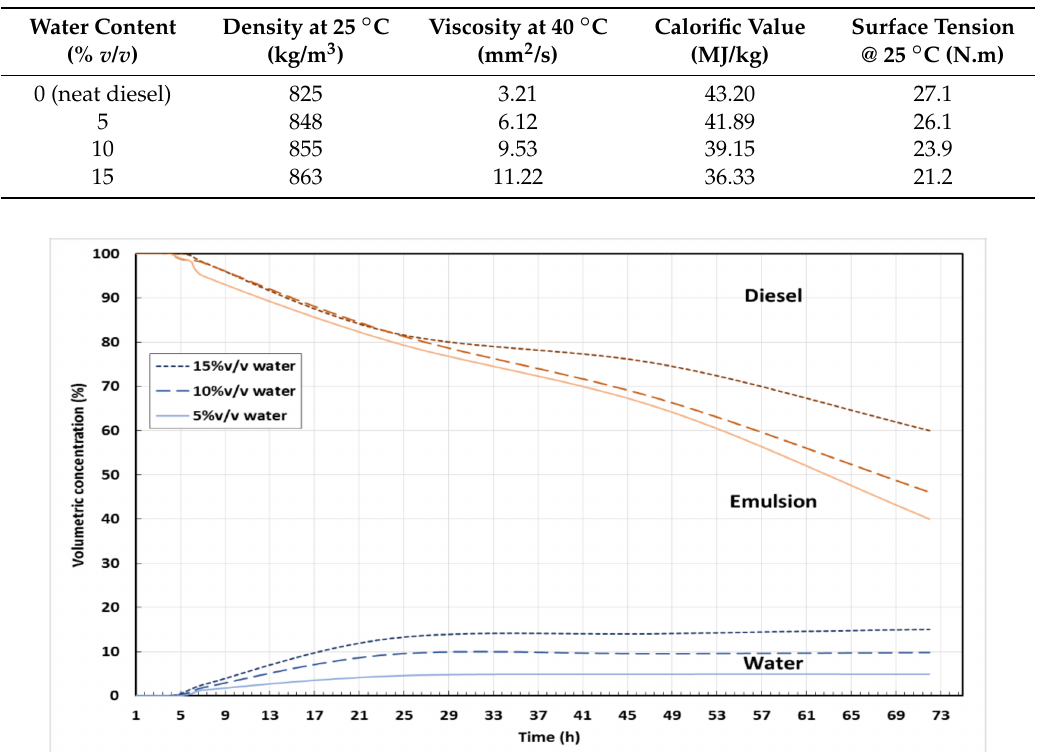
Table 1. Properties of neat diesel and water-in-diesel emulsions.